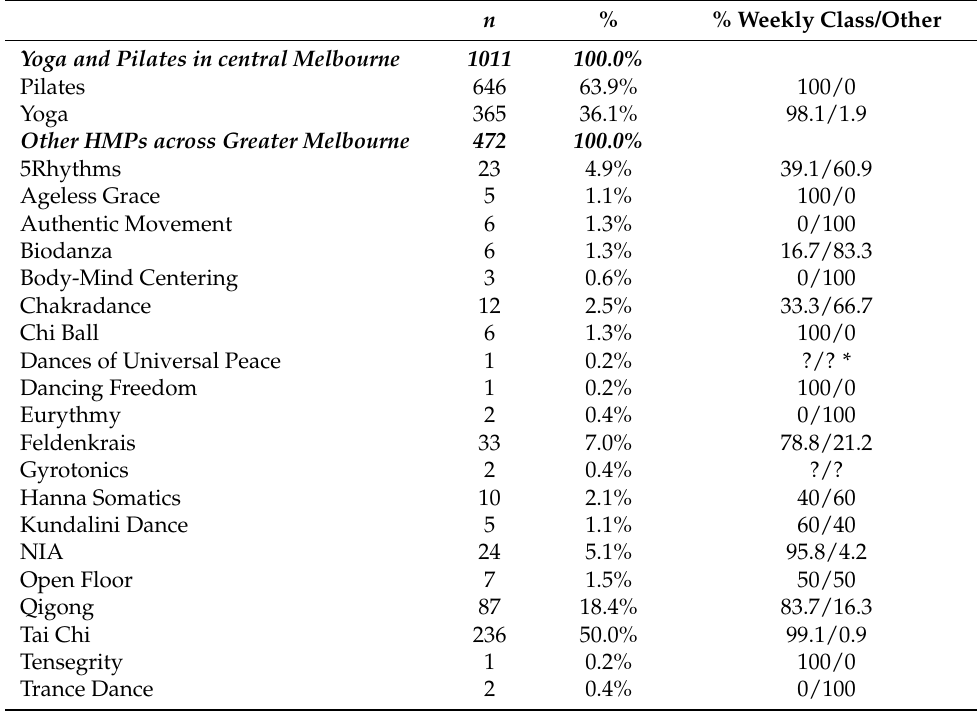
Table 1. Number of events found per HMP, and proportion of weekly classes versus other types of